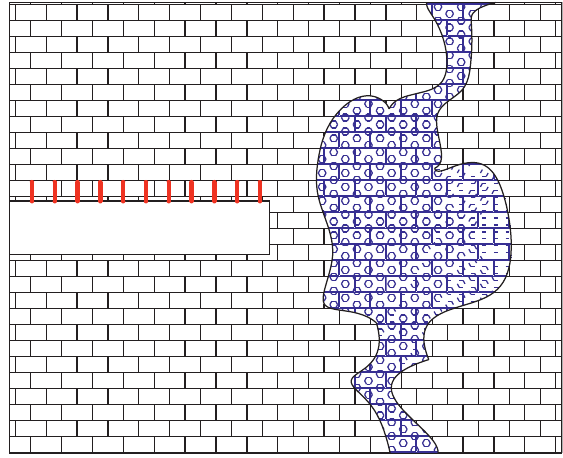
Figure 7: Vertical plane projection of Karst cave